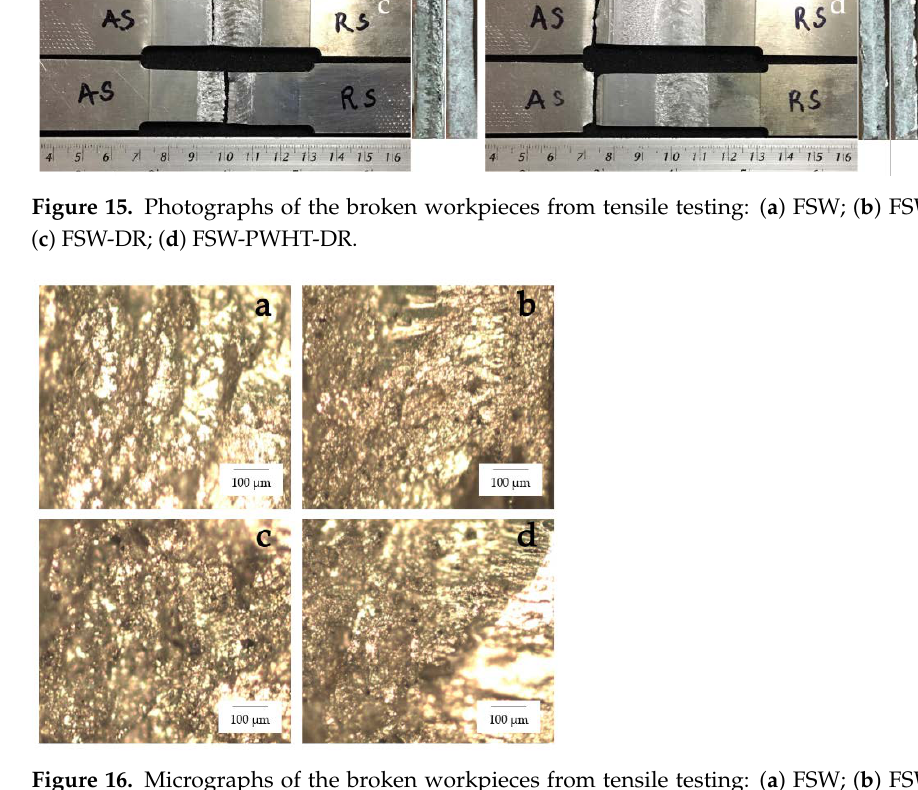
Figure 16. Micrographs of the broken workpieces from tensile testing: ( a ) FSW; ( b ) FSW-PWHT; ( c ) FSW-DR; ( d ) FSW-PWHT-DR. Table 9. Comparison of the tensile strengths of the workpieces.